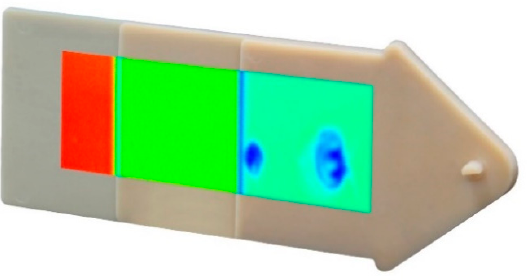
Figure 4. Plastic step wedge made of polyamide. Air pockets are made visible using THz TDS. Adapted from [15], courtesy of TOPTICA Photonics AG.